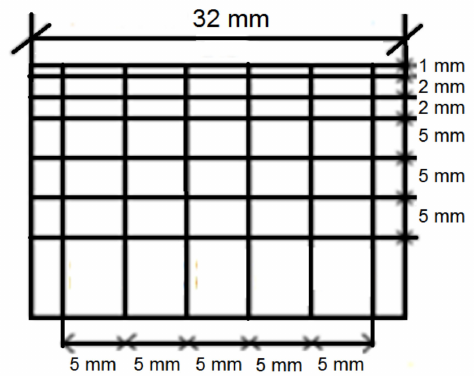
Figure 5. The scheme of the network for surface roughness